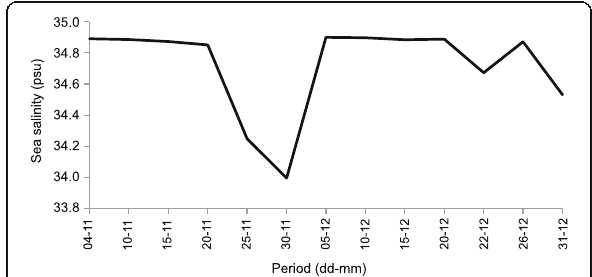
Fig. 5 Surface salinity profile of Bay of Bengal from November 4 to December 31, 2015, obtained from Argo float data. Note that the maximum decline in salinity (~ 1 psu) occurred on November 30, 2015, just preceding the peak flow accumulation on December 1, 2015, when low-saline waters are likely to have been exported from the coastal region including the residual flow from Pulicat lagoon